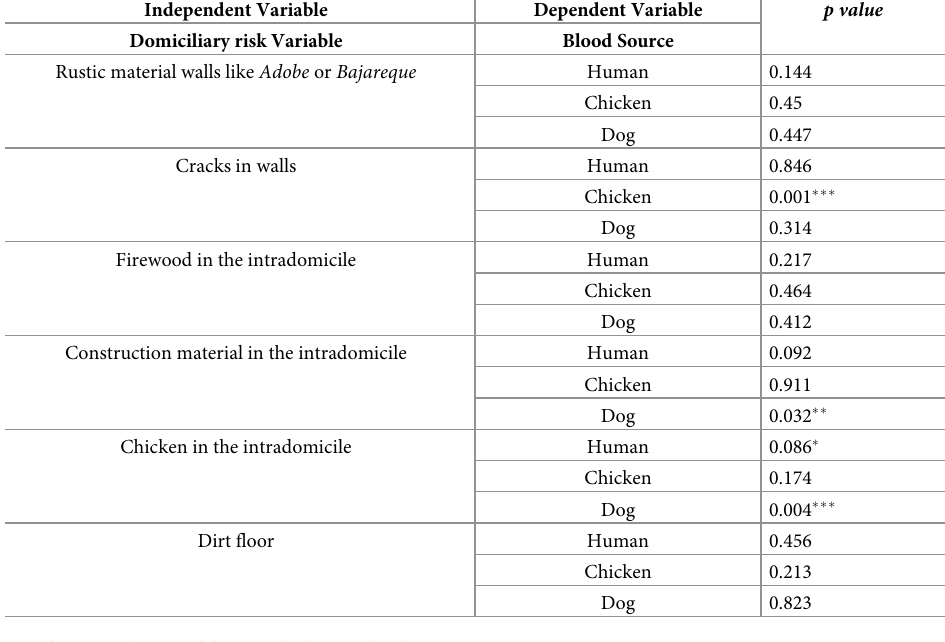
Table 3. Logistic regression results evaluating the association of the domiciliary risk variables with the main blood sources (human, chicken, dog) (N =